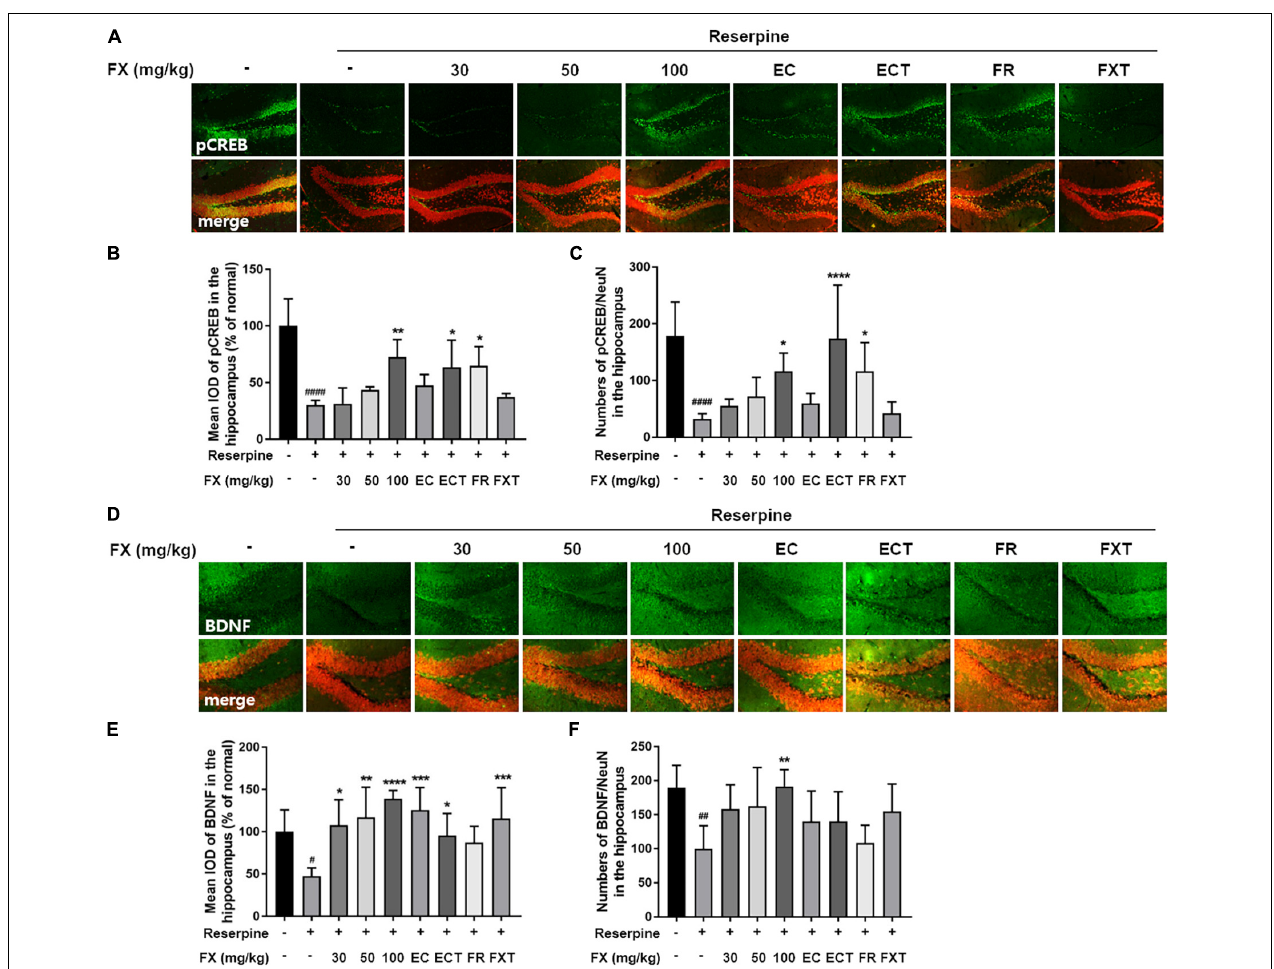
FIGURE 7 | Effect of FX extract and its components on the expression of pCREB and BDNF in the hippocampal neuron. (A–C) pCREB and (D–F) BDNF level were measured in the dentate gyrus of the hippocampus with immunofluorescence ( n = 5). FX extract, ECT, and FR significantly increased pCREB levels in the hippocampal neurons. FX extract, EC, and ECT significantly increased BDNF levels. In particular, FX extract significantly increased BDNF levels in the hippocampal neurons. # P < 0.05, ## P < 0.01, and #### P < 0.0001 vs. normal group; * P < 0.05, ** P < 0.01, *** P < 0.001, and **** P < 0.0001 vs. reserpine